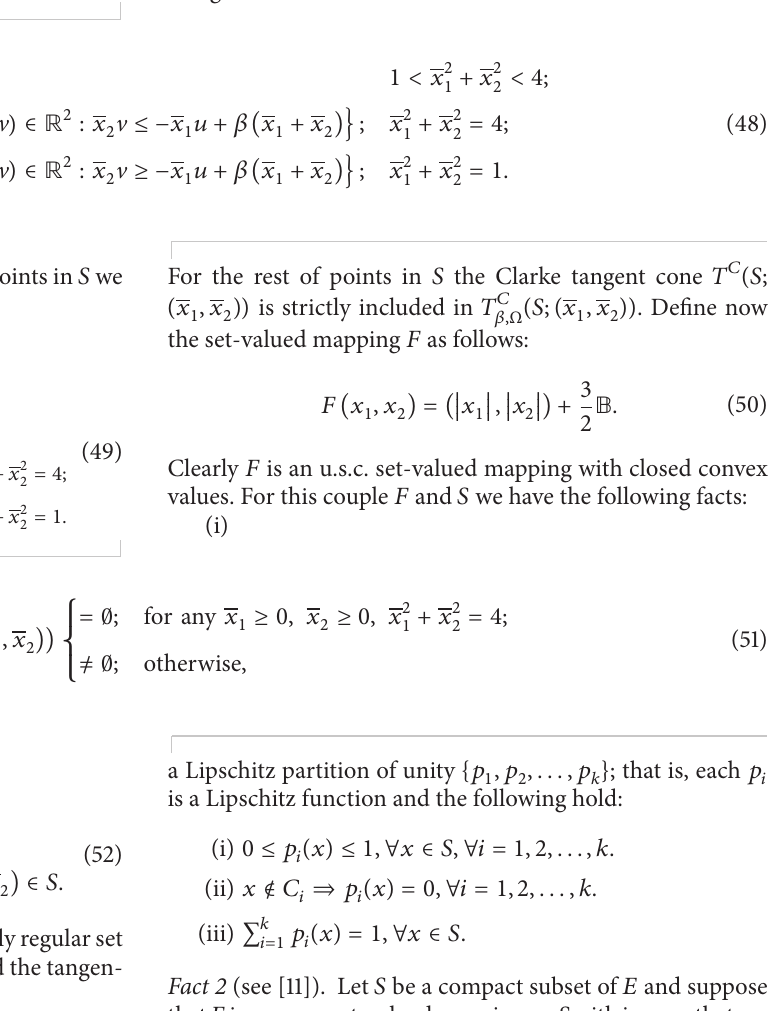
Figure 1: The convex set 𝑆 and the target set Ω in Example